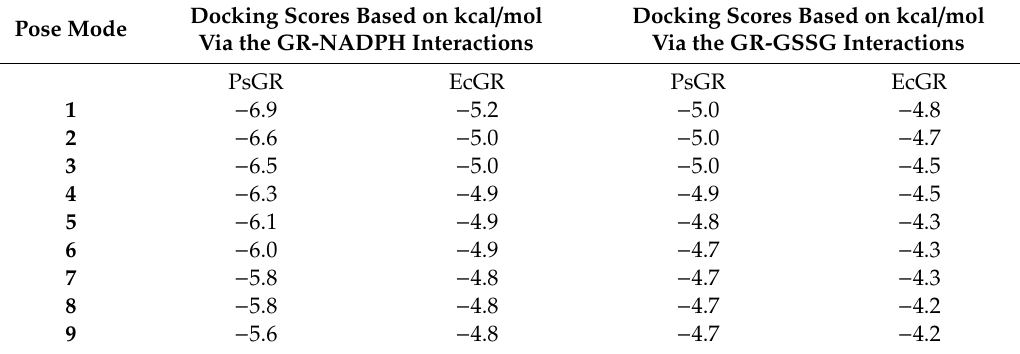
Table 2. Binding energy interactions of PsGR and EcGR with the NADPH and GSSG as ligands.